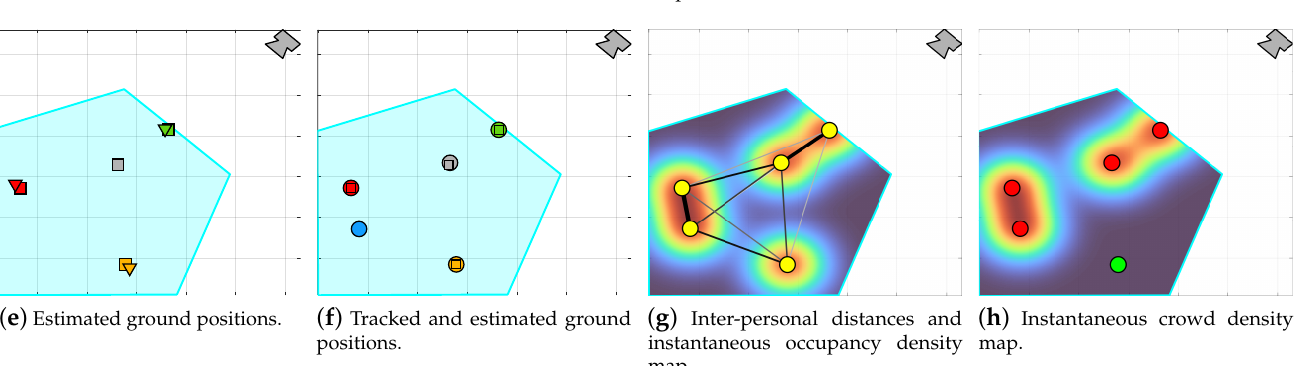
( c ) Inter-personal distances and instantaneous occupancy density map.